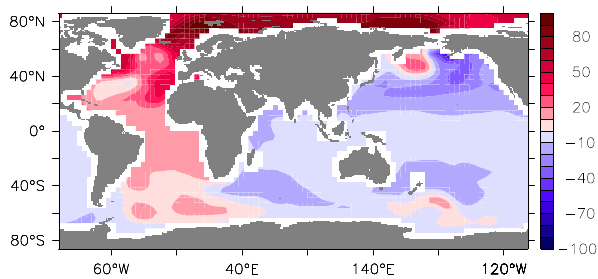
Fig. 1. Equilibrium dynamic sea level change (in cm) after freshwater induced collapse of the AMOC (800yr of forcing as in Levermann et al., 2005).